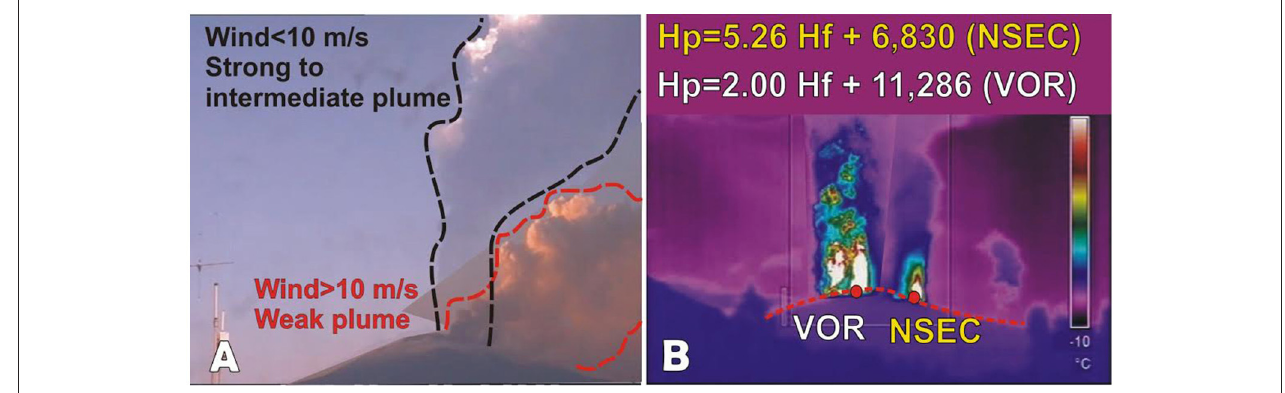
FIGURE 7 | Schemes summarizing the main results obtained in this study. (A) At Mt. Etna wind speed greater than 10 m/s produces a weak plume that bends and is elongated along the wind direction (red outline), whereas wind speed below 10 m/s results in strong to intermediate plumes (black outline), causing a lesser impact on the local population (since the ash fallout is mainly concentrated around the crater, although the upper portion of the eruptive column comprising the fine-grained particles is always affected by wind) but a greater effect on aviation (because the elevation of the ash plume is greater). (B) We have found two simple relationships between plume (Hp) and lava fountain (Hf) heights that could be used for hazard assessment as soon as the lava fountain average height is reached, expressed by the two equations for VOR (Voragine crater) and for the NSEC (New